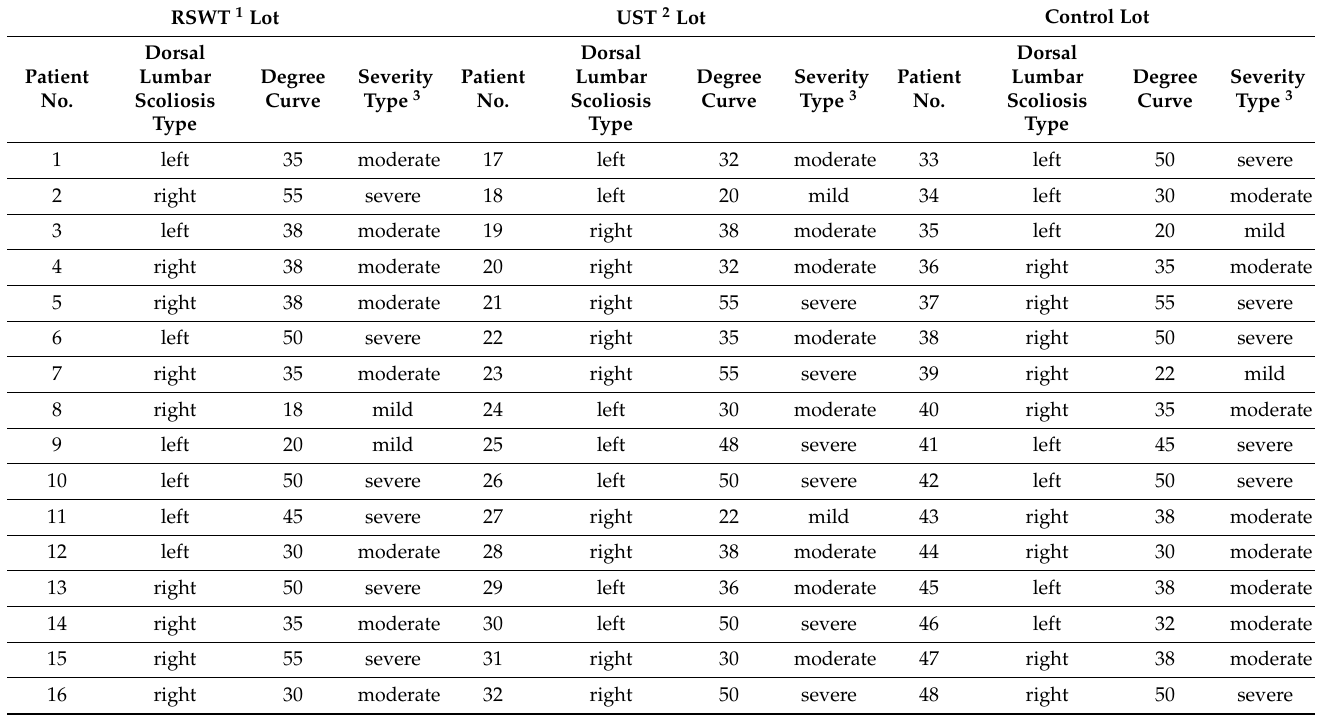
Table 1. Patient characteristics in the three study lots regarding scoliosis type, degree, and severity. RSWT 1 Lot UST 2 Lot Control Lot Dorsal Patient No.